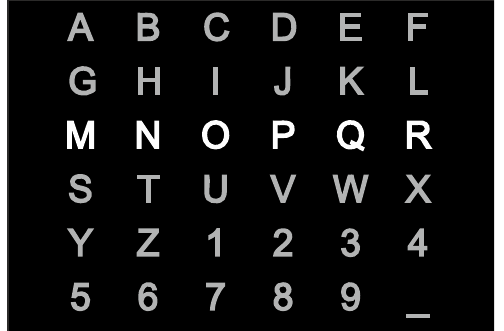
Figure 8. Original P300 speller. Matrix of symbols displayed on a screen computer which serves as the keyboard or prosthetic device (adapted from